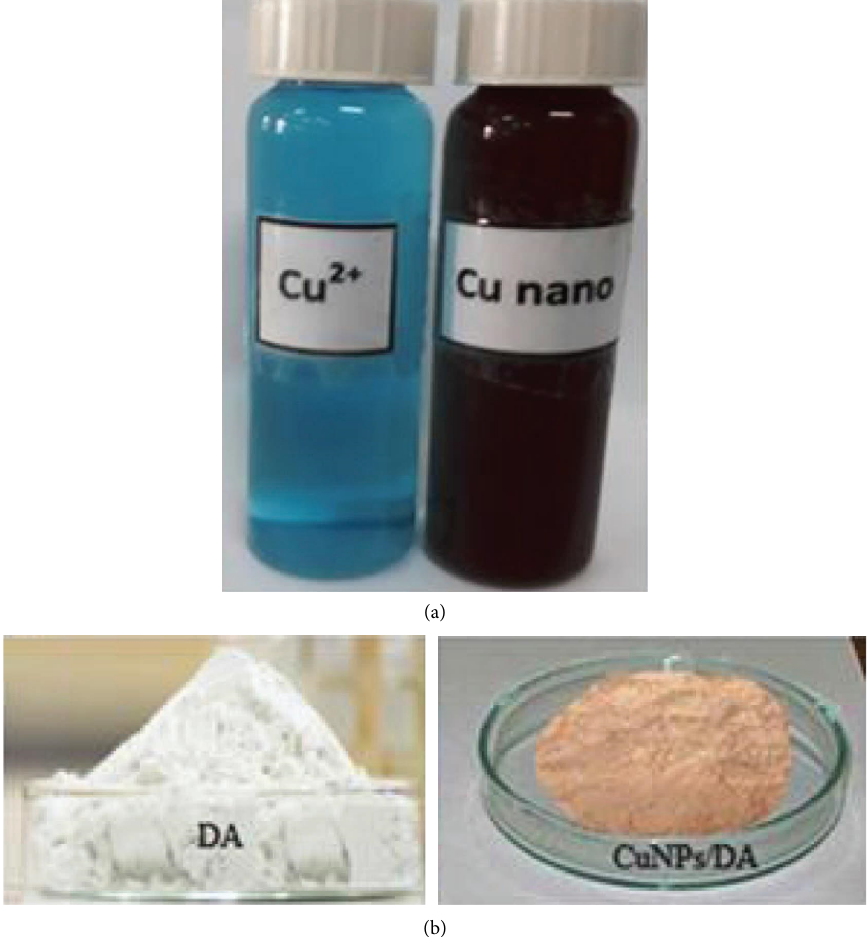
Figure 1: Images of (a) Cu 2+ ions and colloidal Cu nano; (b) powders of DA and